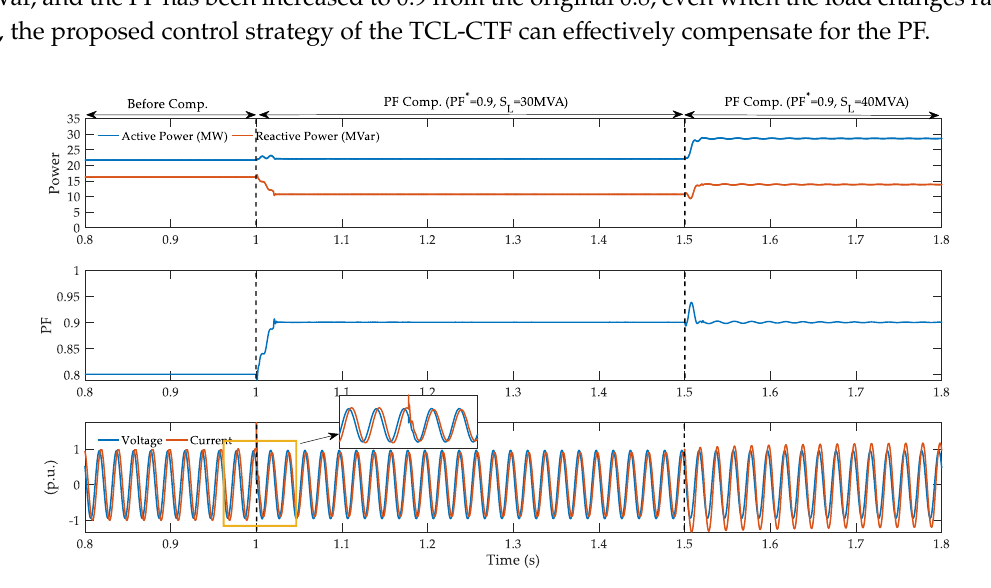
Figure 20. Simulation results of reactive power compensation by using the TCL-CTF.